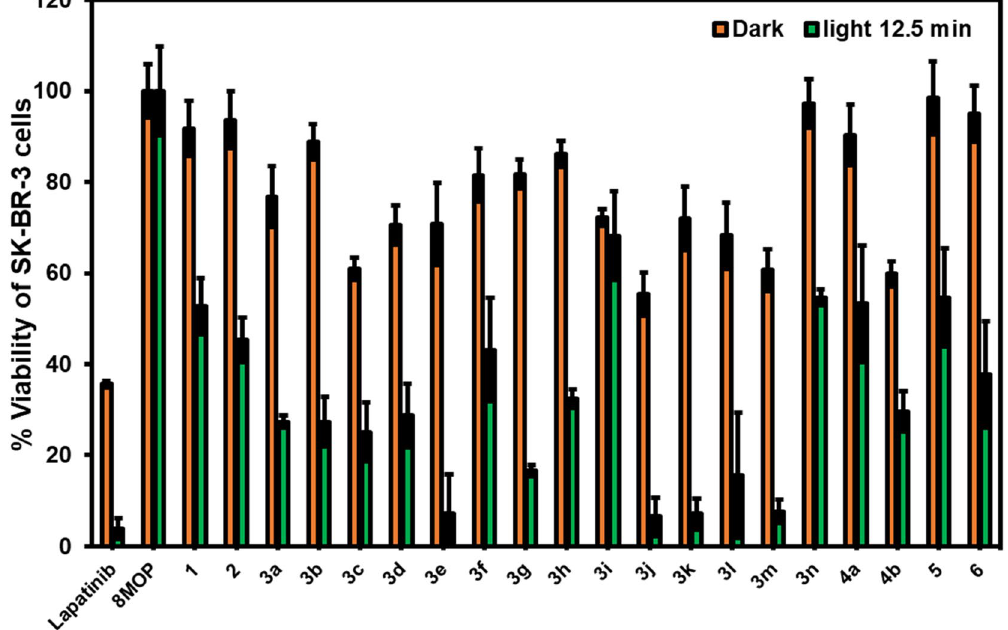
Figure 3. Dark and light-activated cytotoxicity of psoralen derivatives against SK-BR-3 at the concentration of 50 µM; orange bar = %viability in the dark, green bar = %viability under irradiation with UVA (2.0 J cm −2 ).